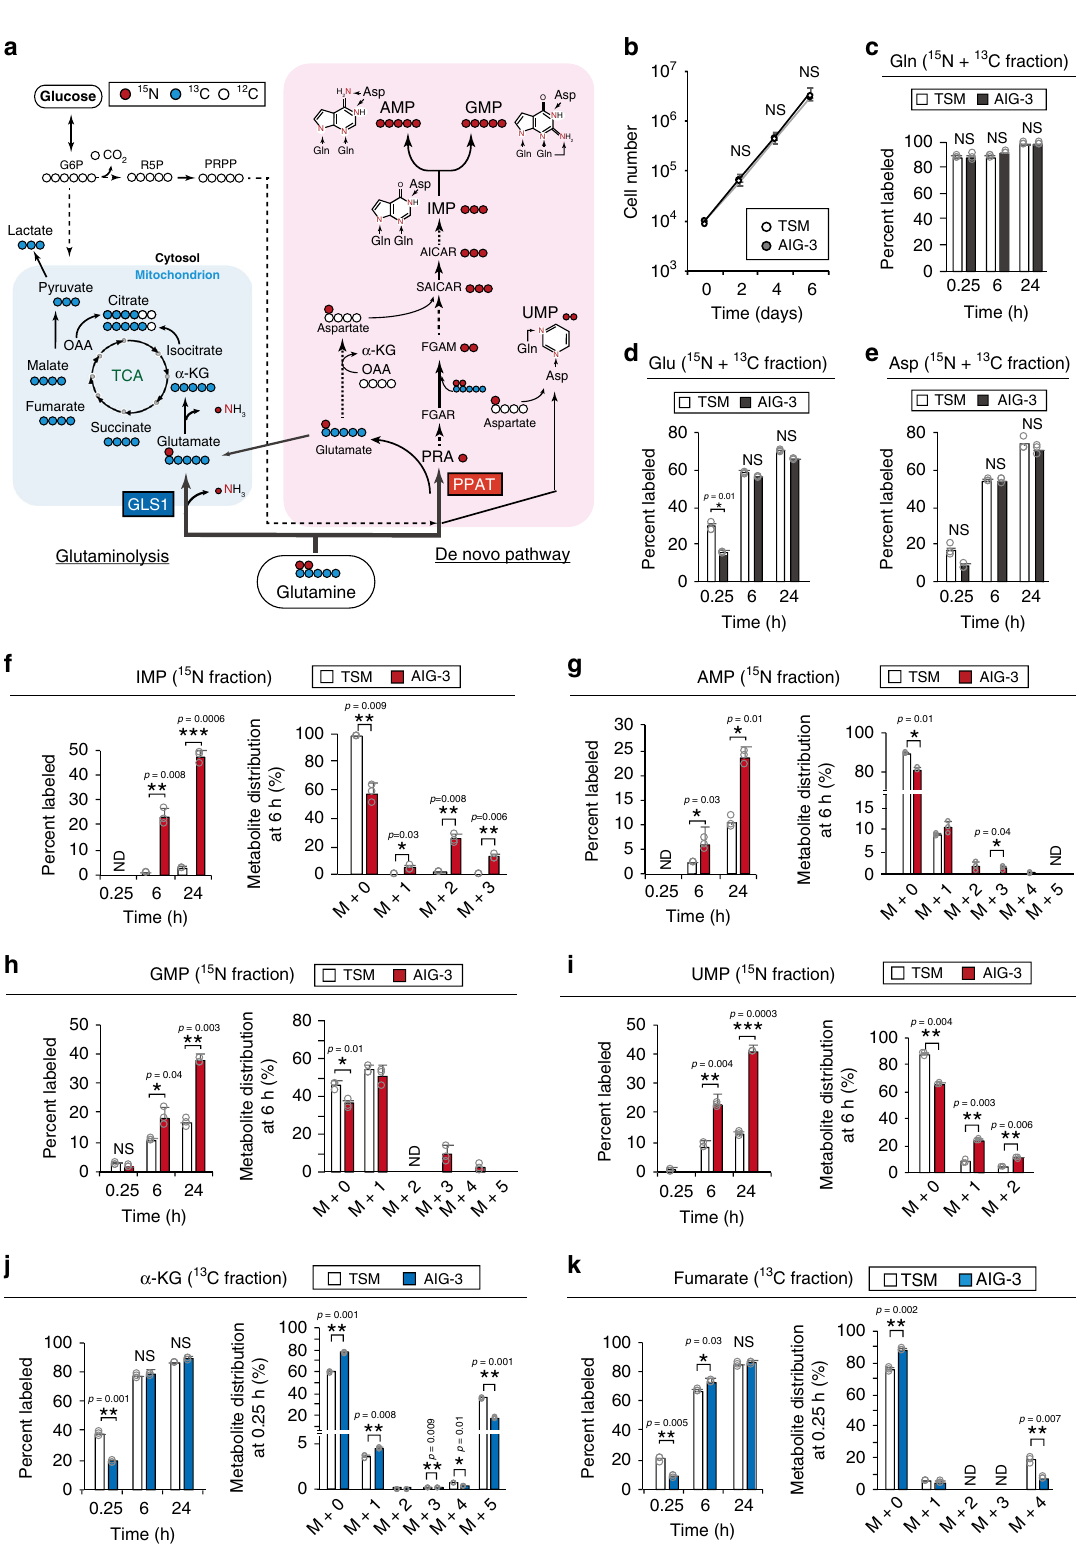
PPAT/GLS1 ratio varied substantially among these cell types (Fig. 5a). Breast, brain, and lung cancer cells manifested a rela- tively high PPAT/GLS1 ratio, whereas stomach and colorectal cancer cells showed a low PPAT/GLS1 ratio. Cells with a high PPAT/GLS1 ratio such as BT-549 breast cancer cells (Fig. 5b), TGW neuroblastoma cells (Fig. 5c), and U-251 MG glioblastoma